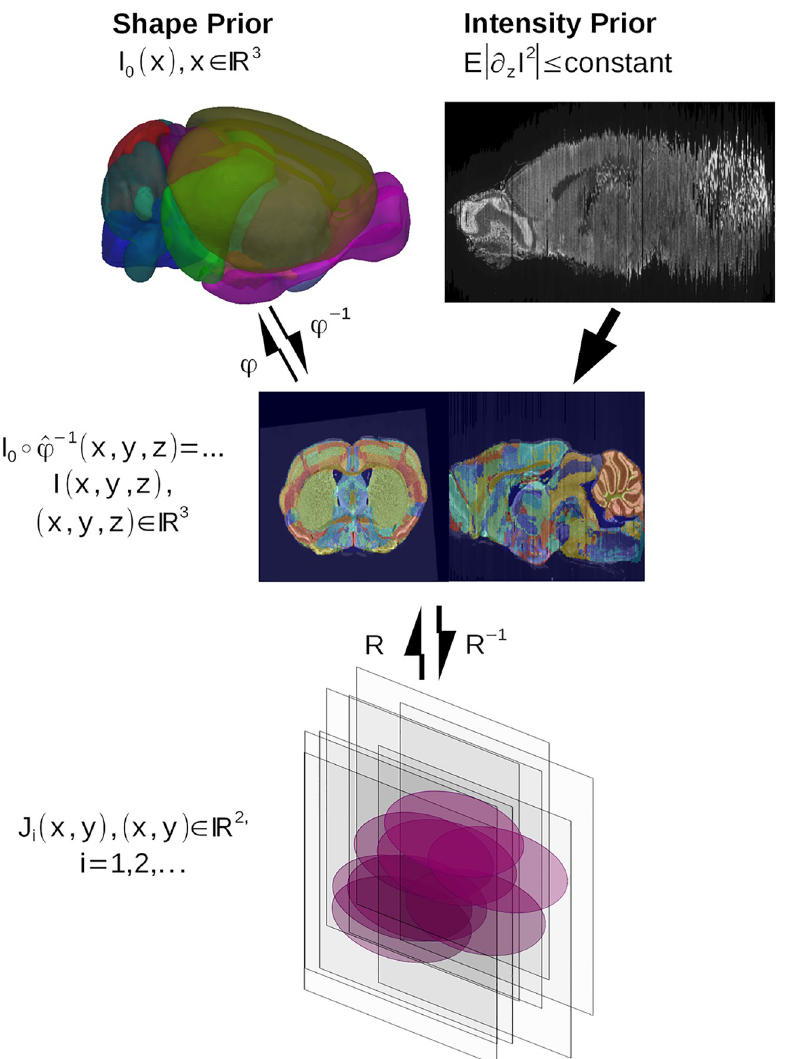
Fig 1. The histological sectioning model. The template I 0 , the mouse brain in the orbit I 2 I and observed histological sections J i , i = 1, ... , n are illustrated. The Sobolev image intensity prior and the shape prior are depicted in the top row. The model shows the template and mouse brain as elements of the same orbit I exists diffeomorphism I = I 0 � φ − 1 , φ 2 Diff